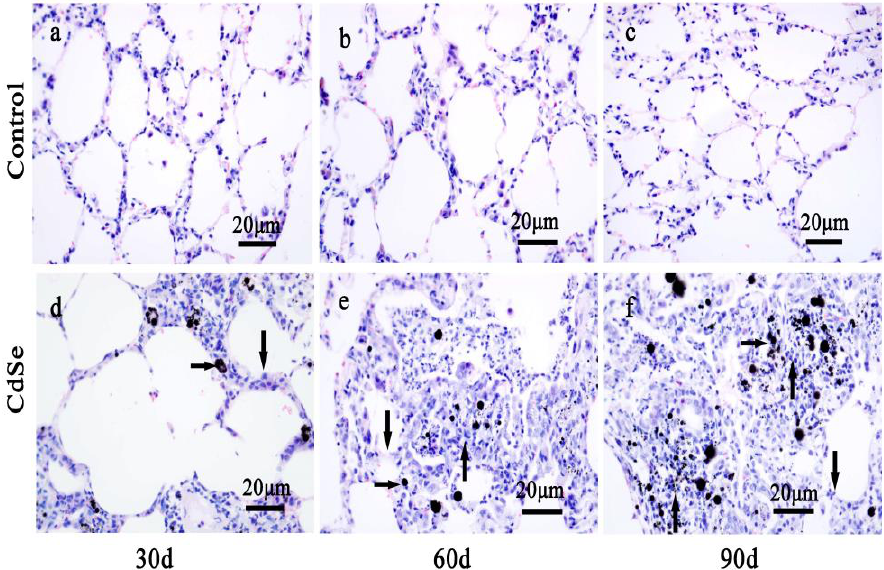
Figure 1. The alteration of lung tissue pathological morphology of SD rats induced by CdSe nanorods. The control groups that pulmonary instillation with saline for 30 days ( a ), 60 days ( b ), and 90 days ( c ). Pulmonary instillation CdSe nanorods for 30 days ( d ), 60 days ( e ), and 90 days ( f ). Blackspots are CdSe nanorods-positive sites (right arrows), the lung tissues from CdSe nanorods-exposed rats showed alveolar mucosa with swelling (down arrows), nodular histiocyte hyperplasia (up arrows), and injury. The above typical pictures are selected from the lung tissues of 8 rats in each group.